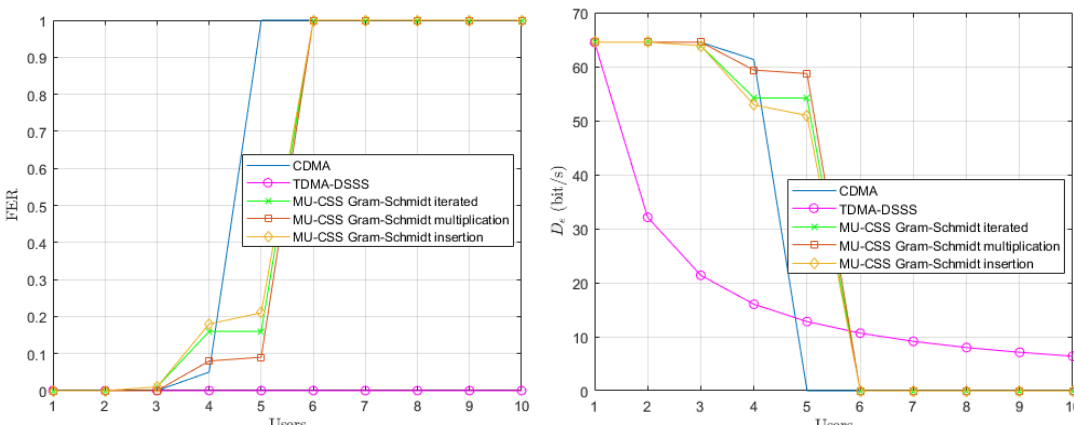
Figure 12. Average FER performance versus number of users for the Ty-Colo lake with the replayed channel with mobile users ( left ), and average effective data rate per user versus number of users for the Ty-Colo lake with the replayed channel with mobile users ( right